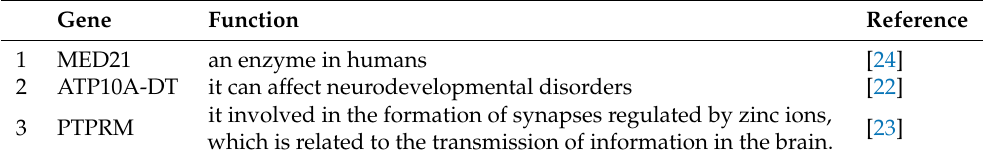
Table 3. The function of the novel significant genes. ATP10A-DT and PTPRM are related to brain devel- opment and neurodevelopment. The third column shows the reference that supports the gene function. Gene Function Reference an enzyme in humans